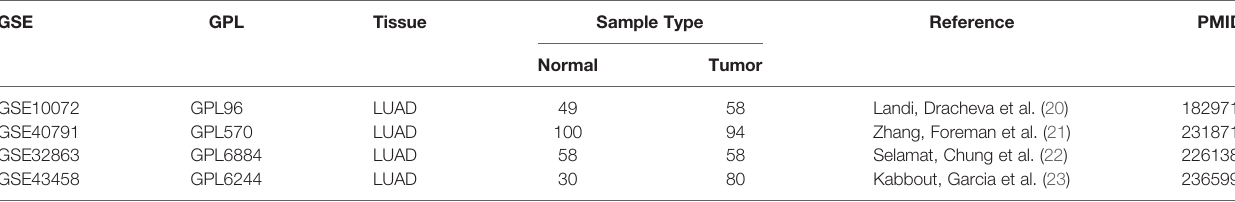
TABLE 3 | Characteristics of four GEO datasets in lung adenocarcinoma. GSE GPL Tissue